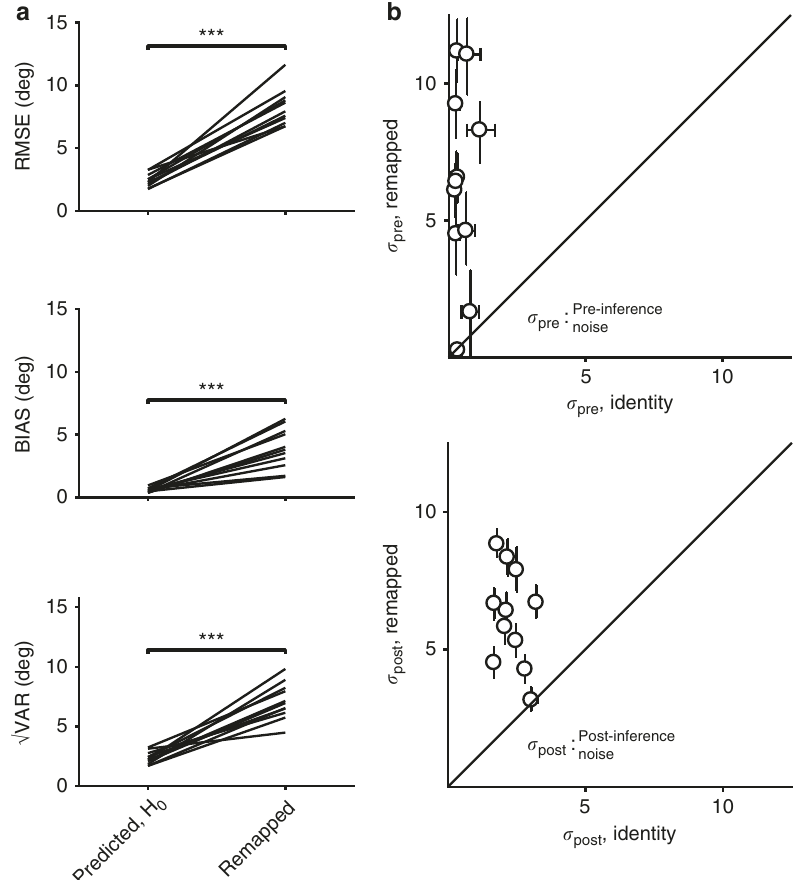
Fig. 7 Summary of subjects ’ performance in the center-out reaching task, visuomotor rotation = 60°. a Comparison of RMSE, BIAS, and √ VAR for all subjects. On the left are values from individual subjects in the identity context; on the right are the values observed from behavior in the remapped context. Similar to the timing and length production tasks, subjects had higher error and were more biased towards the mean than was predicted assuming no MTN. Variability was also substantially increased in all subjects (***: p <0.001, Wilcoxon two-sided signed-rank test). b Fitting the observer-actor model independently across the two contexts resulted higher values of σ pre in the remapped context, re fl ecting additional reliance on prior information consistent with a late inference strategy. Values for σ post were also substantially increased. Error bars represent 95% con fi dence intervals estimated using a bootstrap procedure ( n =